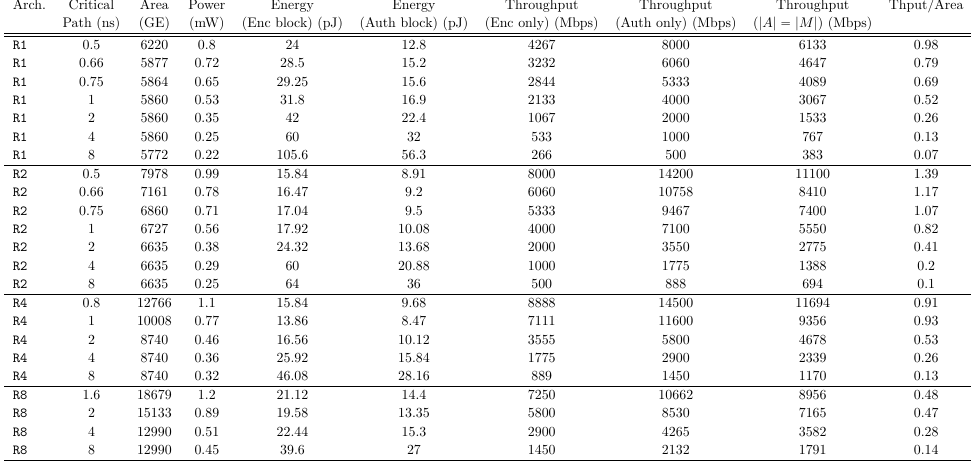
Table 10: The design space of Romulus - N 1 using the TSMC-65 ASIC technology: (unrolled) round-based implementations Arch. Critical